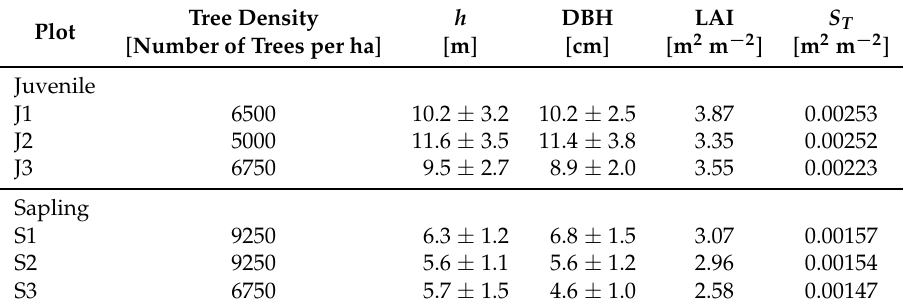
Table 1. Characteristics of balsam fir trees inside the 400-m 2 plot: tree density per hectare (extrapolated from the number of trees in 0.04 ha), canopy height ( h ), diameter at breast height (DBH), leaf area index (LAI) and sapwood area per unit ground area ( S T ). Values are mean ± standard deviation.